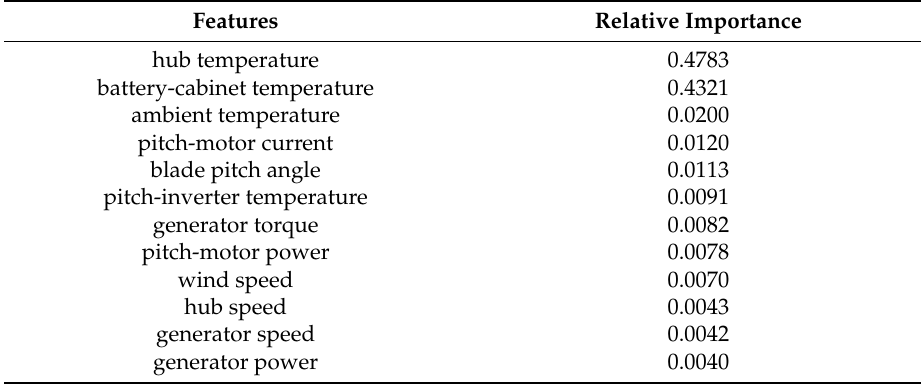
Table 3. The relative importance of